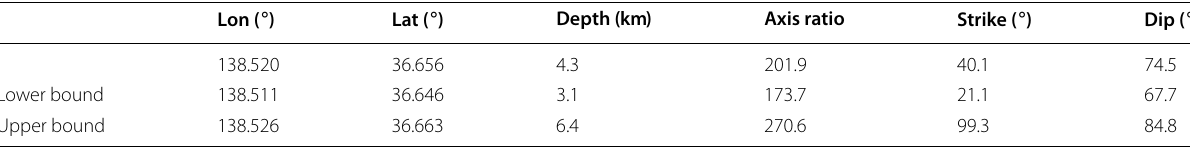
Lower and upper bounds represent 95% credible intervals